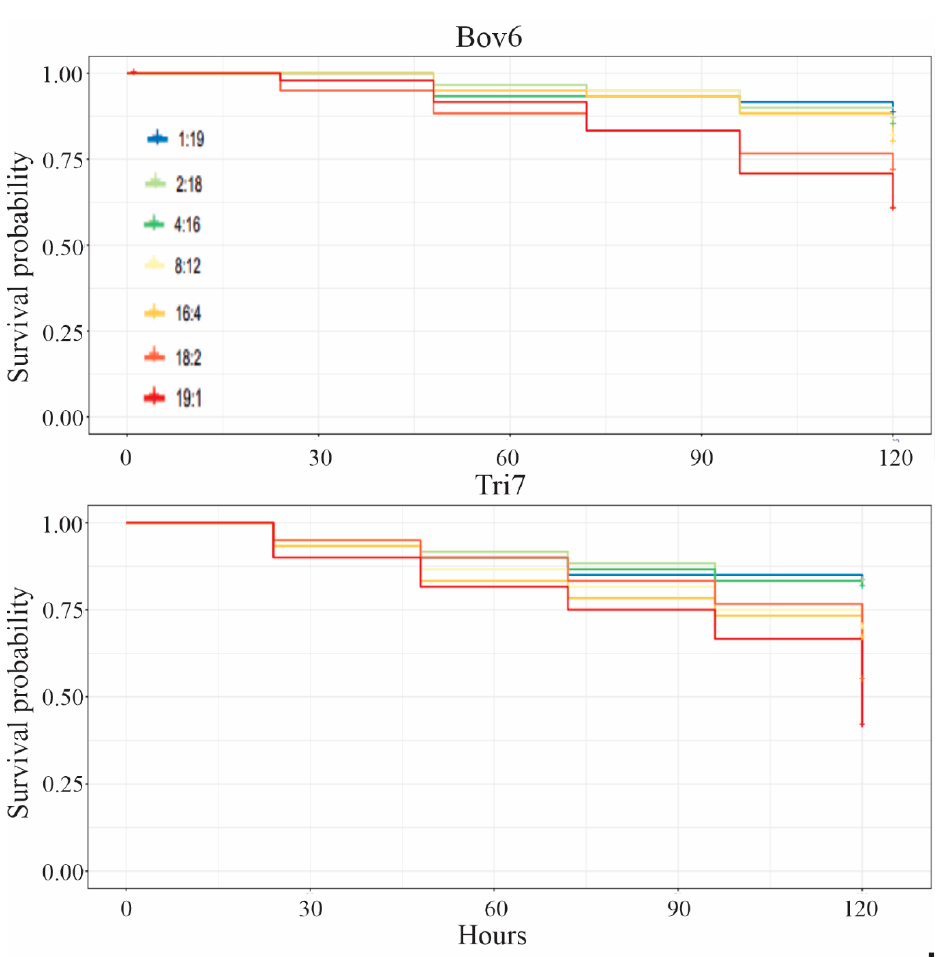
* p -values significant in bold ( p < 0.05).